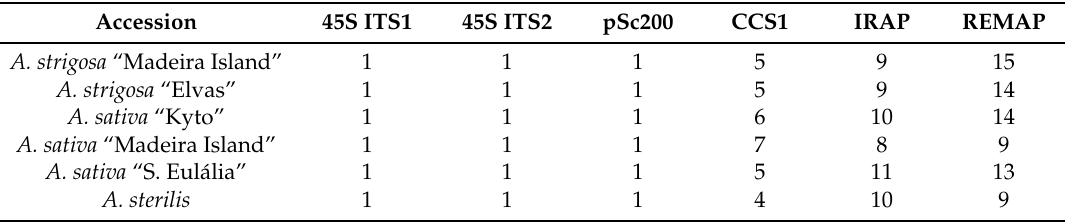
Table 1. Number of bands per banding profile obtained in each PCR experiment. Accession